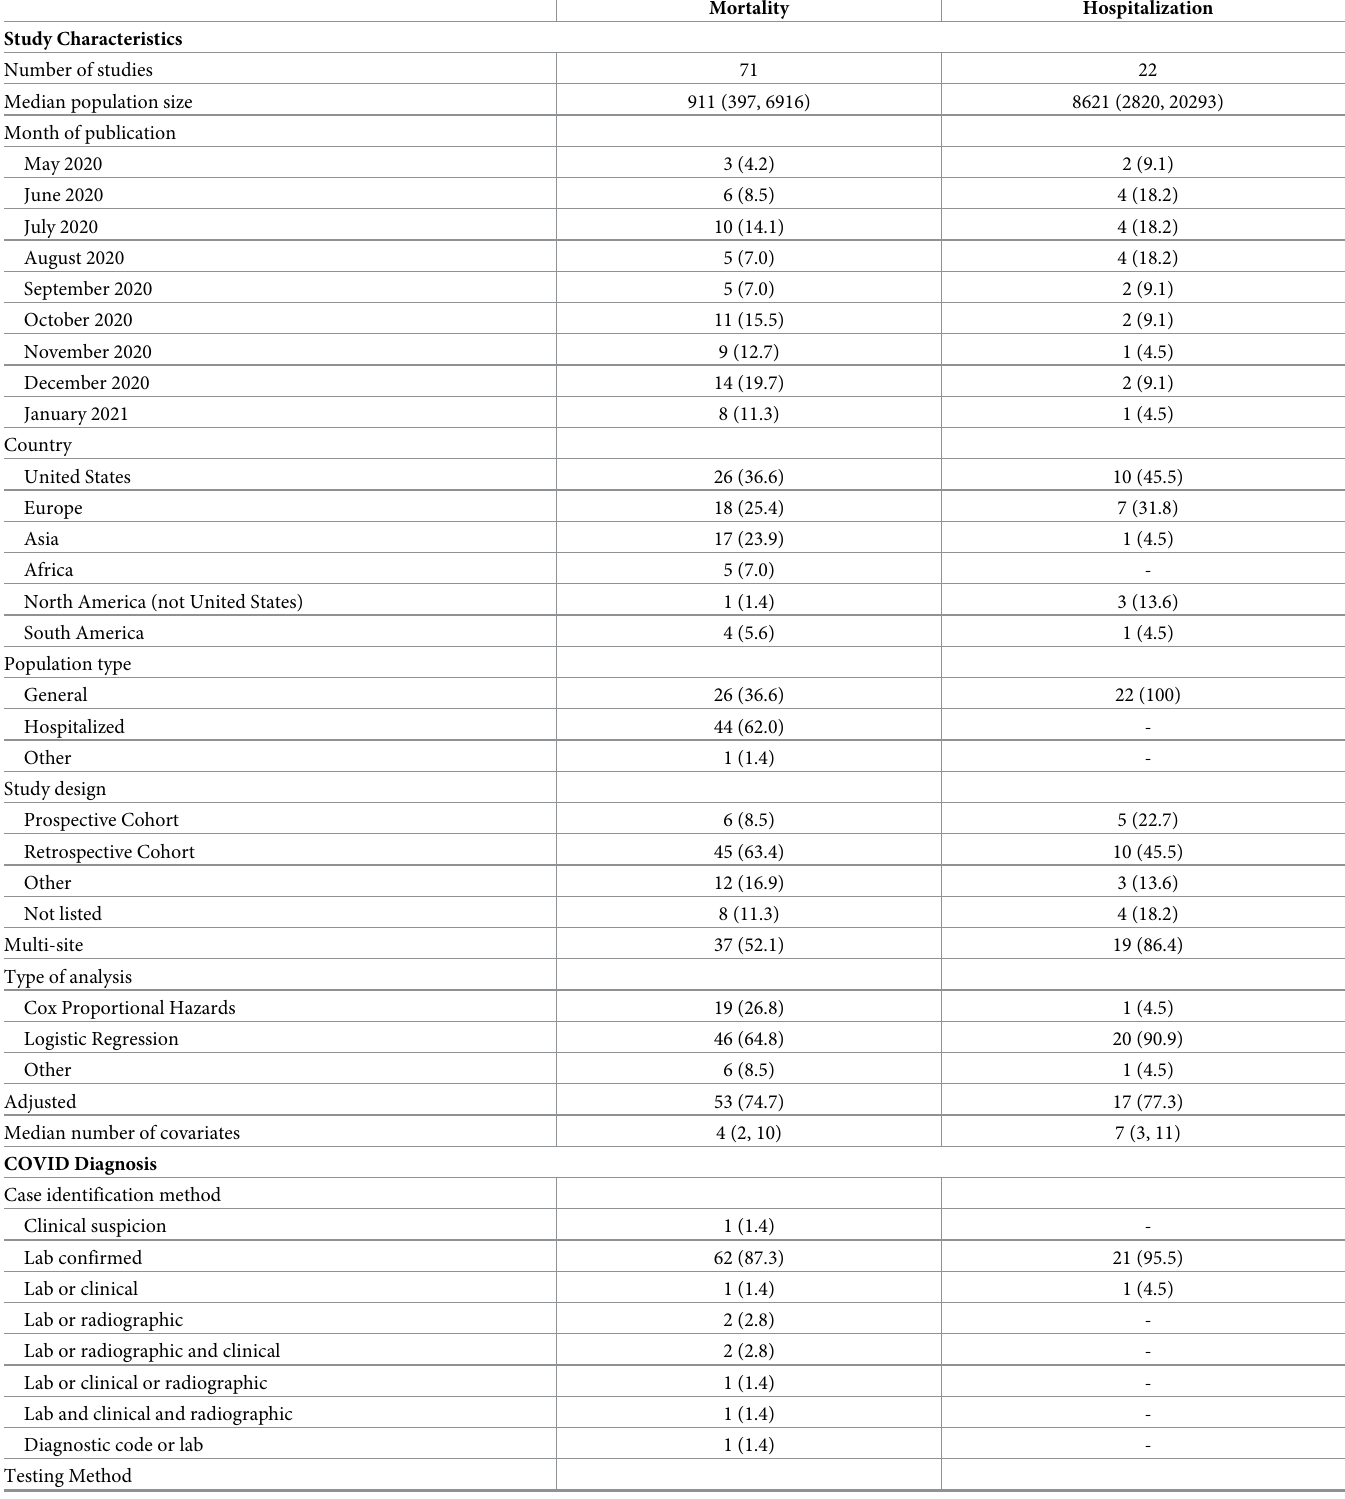
Table 1. Characteristics of mortality and hospitalization studies (N (%) or median